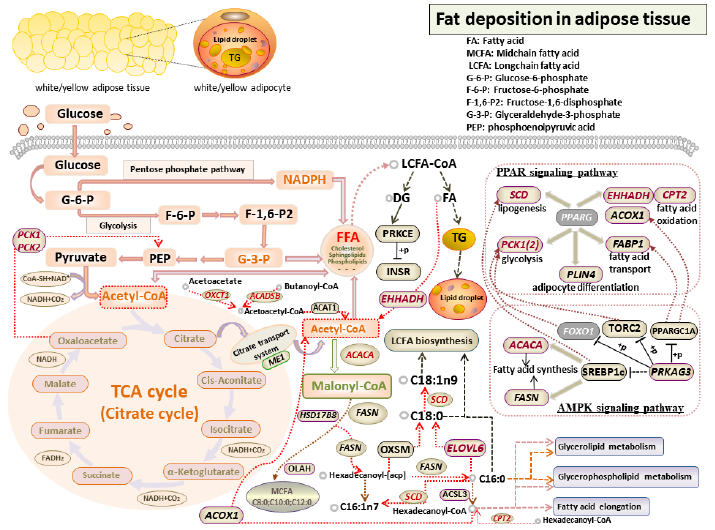
Figure 12. Map of the regulatory mechanisms of candidate genes regulating fat deposition.